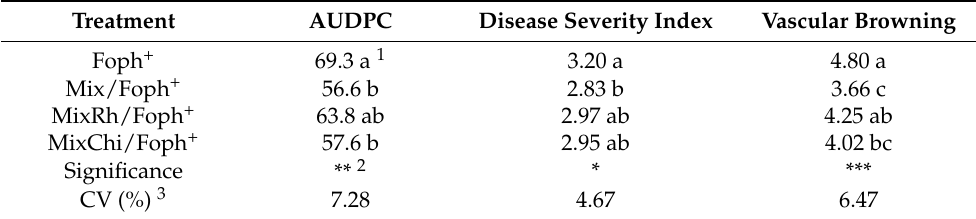
Table 1. Area under the disease progress curve (AUDPC), severity, and vascular browning index of vascular wilt caused by Fusarium oxysporum f. sp. physali (Foph) in cape gooseberry seedlings with or without treatment using mixtures of BCAs and organic additives [Mix ( T. virens + B. velezensis ), MixRh ( T. virens + B. velezensis + burnt rice husk) and MixChi ( T. virens + B. velezensis +